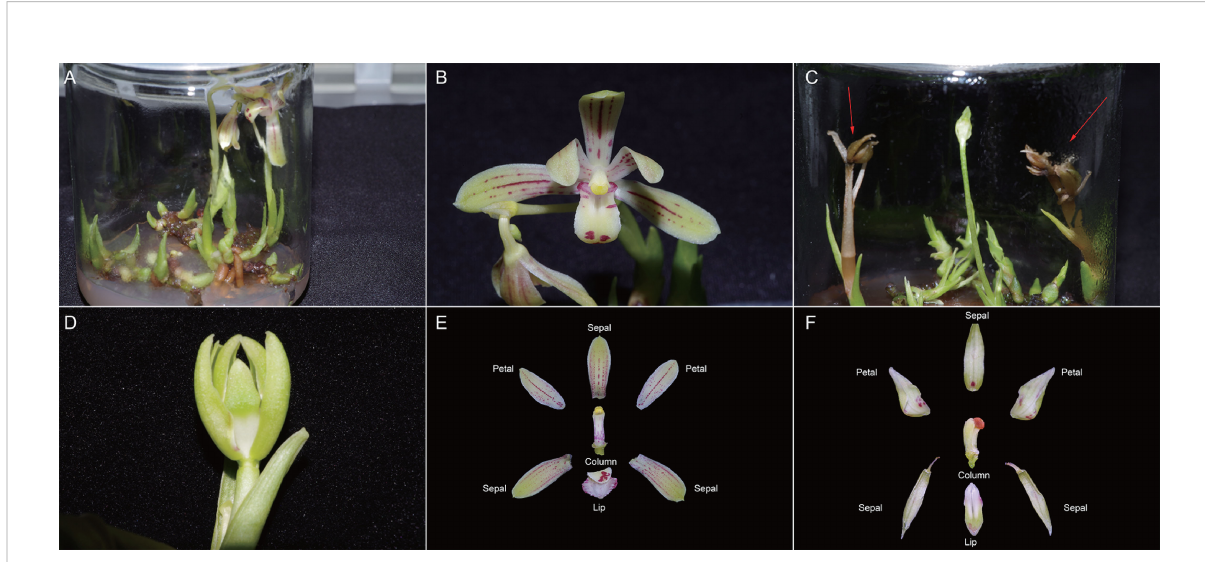
FIGURE 1 C. nanulum Y. S. Wu et S. C Chen fl ower in vitro and primary data reliability test. (A, B) Normal fl owers; (C, D) Abnormal fl owers, red arrow shows dead fl owers before bloom. (E) The different organs of the normal fl owers. (F) The different organs of the abnormal fl owers. Generally, orchid fl owers consist of three outer tepals similar to one another, two distinct inner lateral tepals, and a highly differentiated inner median tepal or